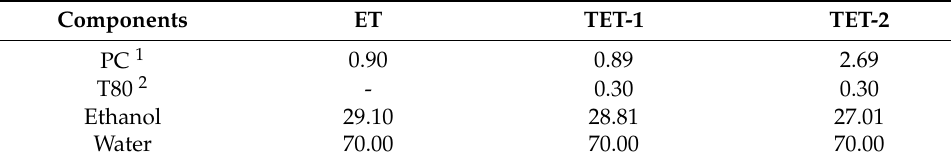
Table 1. Composition of nanovesicular systems ( w / w %).